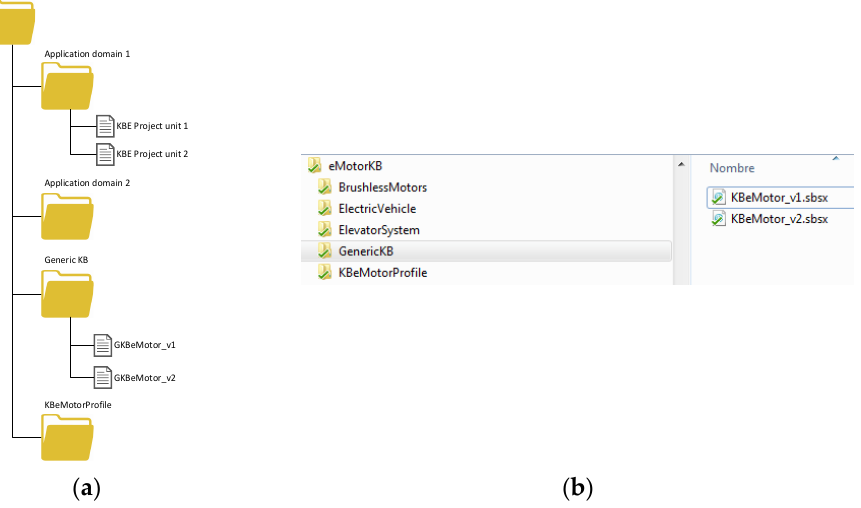
Figure 9. ( a ) Organization of folders with knowledge base (KB) units and profiles. ( b ) Example in a repository.